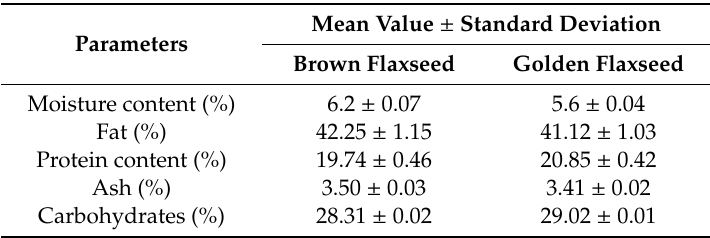
Table 2. Parameters of brown and golden flaxseed